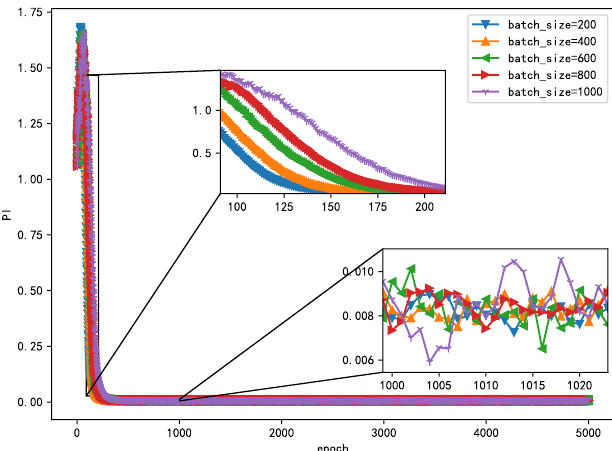
Figure 8. Learning curves of different batch _ size algorithms.